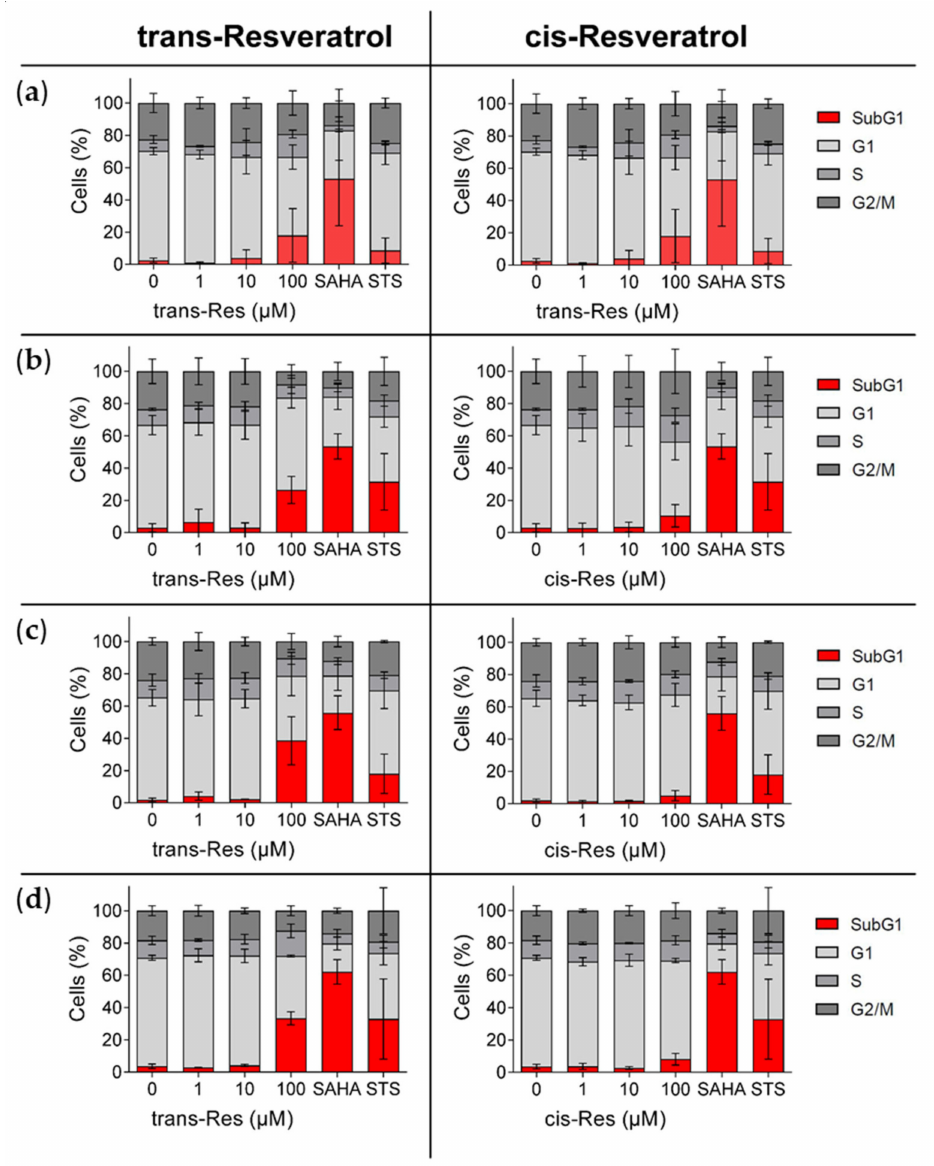
Figure 6. Cell cycle analysis and evaluation of apoptosis in hepatoma and colon carcinoma cells by trans- versus cis-resveratrol, measured after propidium iodide staining by flow cytometry. ( a ) HepG2, ( b ) Hep3B (hepatoma), ( c ) HCT-116, and ( d ) HCT-116/p53 ( − / − ) (colon carcinoma) cells were exposed to different concentrations of trans- and cis-resveratrol (1 µ M, 10 µ M, 100 µ M) for 72 h; 10 µ M SAHA was applied as positive control and 5 µ M STS as control for apoptotic cell death. The proportion of the subG1 fraction of the cells within the cell cycle phases is shown in red. Experiments were replicated in three independent experiments. Error bars represent mean ± SD. Res, resveratrol; SAHA, suberoylanilide hydroxamic acid; STS,